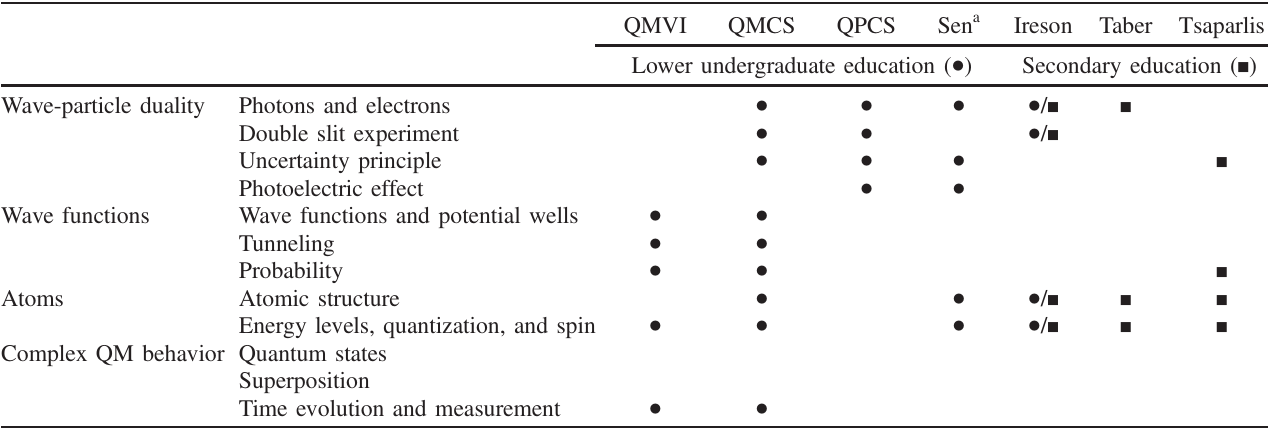
TABLE V. Topics covered by the research